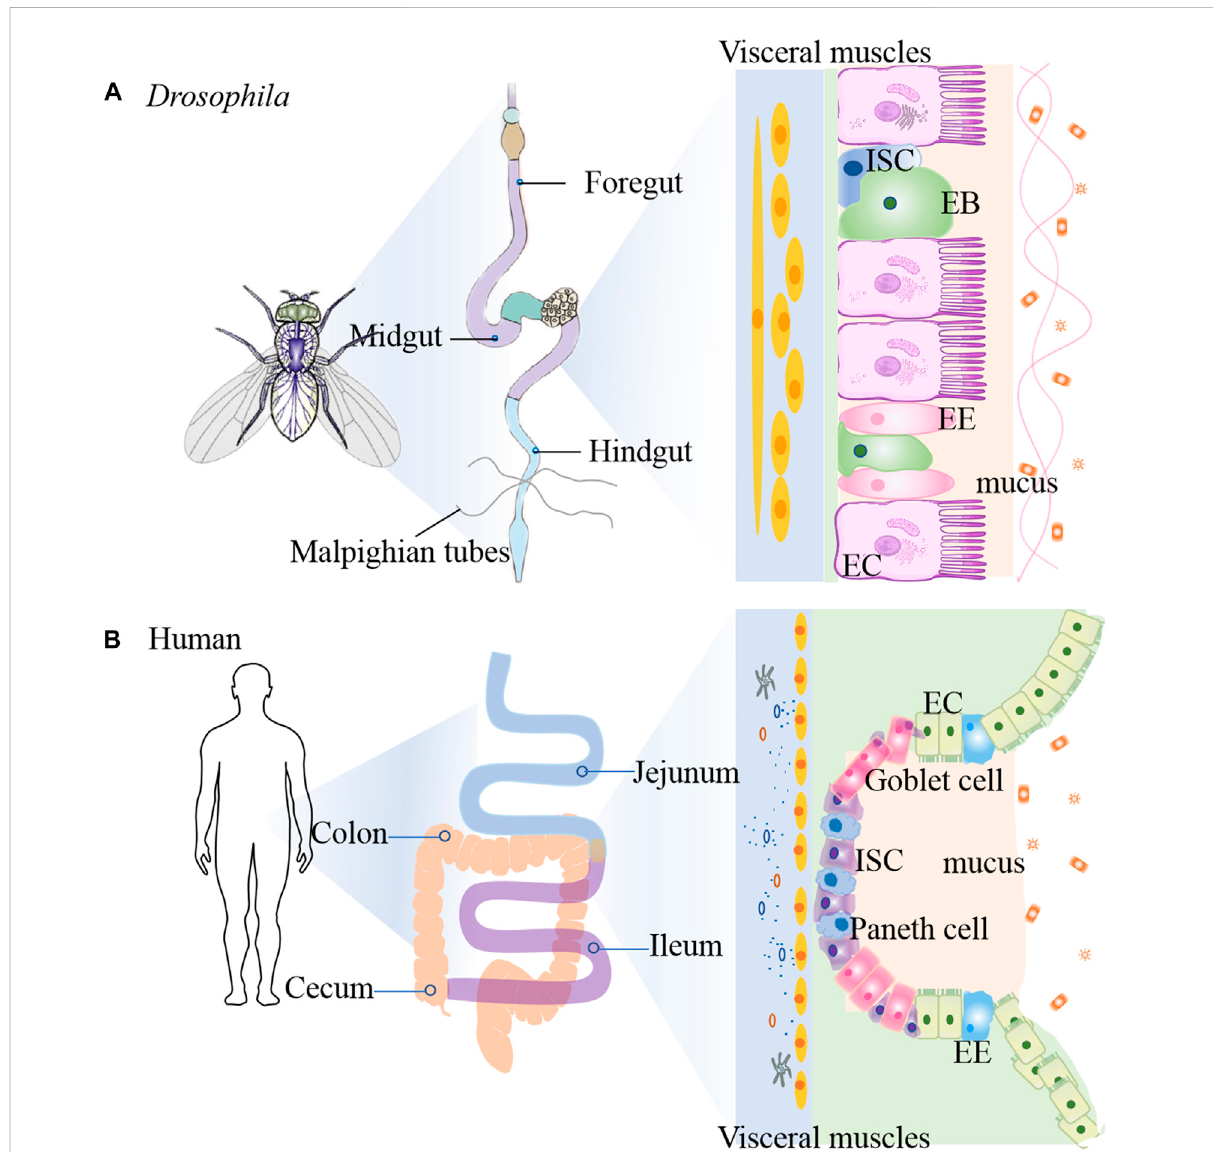
FIGURE 2 Comparison of intestinal tract anatomy between adult Drosophila melanogaster and human. The adult Drosophila (A) and human (B) intestinal tracts share structural and functional